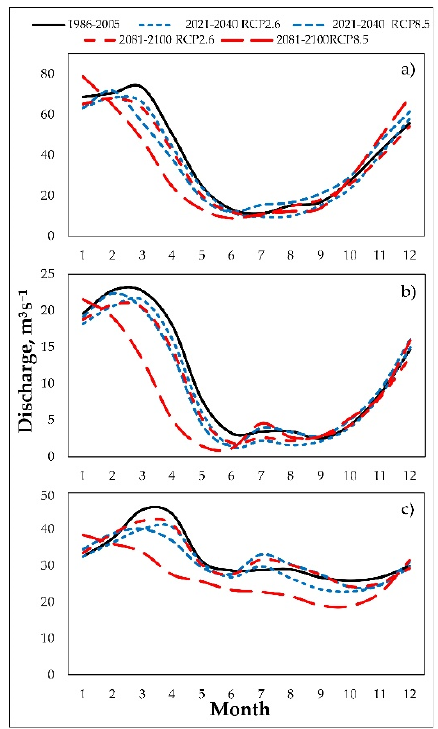
Figure 3. Projected discharge variation in the investigated rivers in the 21st century: ( a ) J ū ra River, ( b ) M ū ša River, and ( c ) Merkys River. ( b ) M¯uša River, and ( c ) Merkys